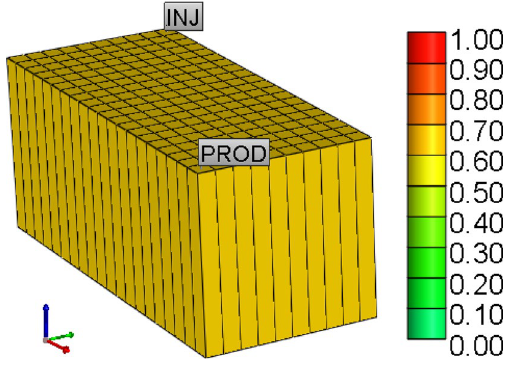
Fig. 11 Core sample 3D model. The color legend shows the initial oil saturation